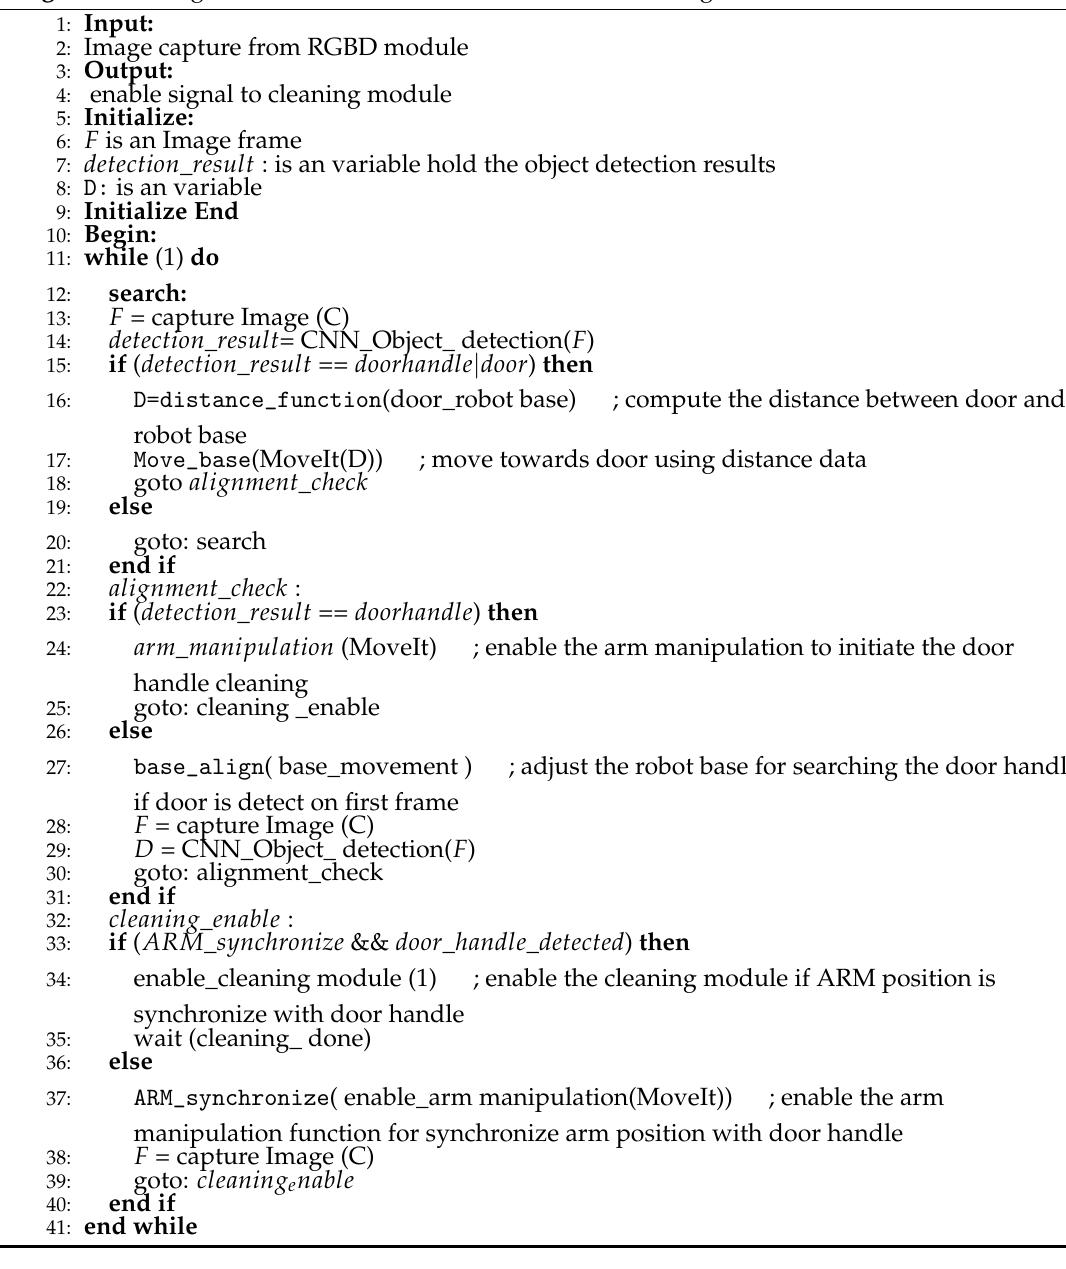
Algorithm 1: Algorithm for door handle detection and